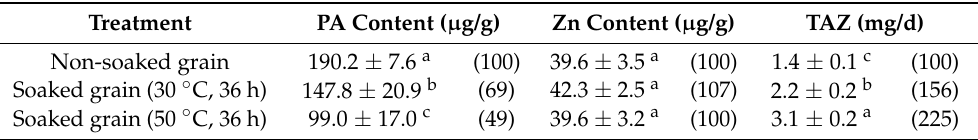
Table 1. Zn bioavailability of non-soaked and soaked grains at 30 °C and 50 °C 36 h after soaking. Data are shown as the mean ± standard deviation from three replicates. Values in parentheses indicate the percentage of the mean value in non-soaked grains. Different letters indicate statistical differences (Tukey’s HSD test, p < 0.05) between treatments.